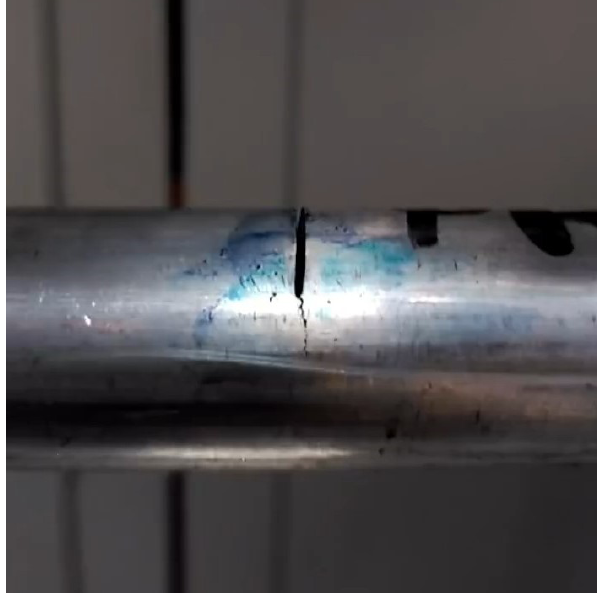
Figure 17. Detail of the notch and the crack of one of the